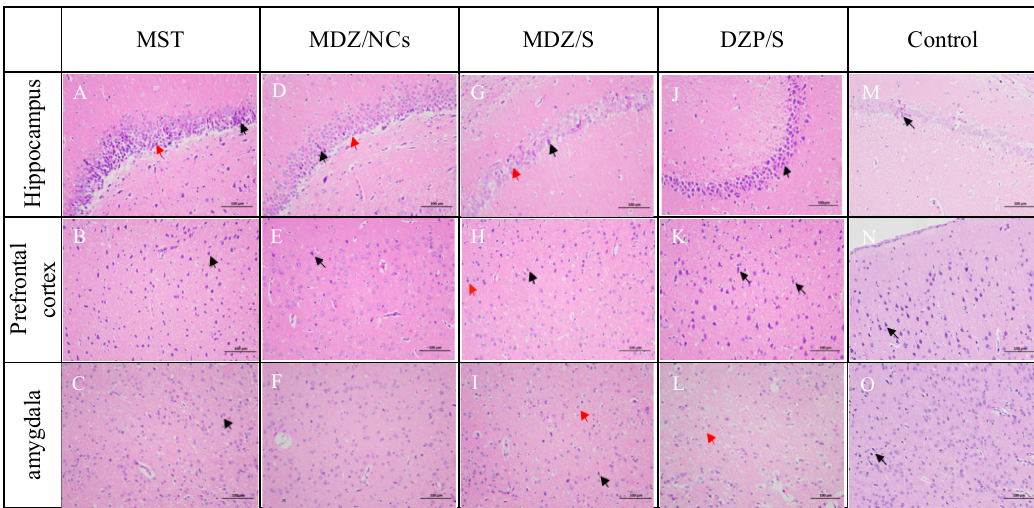
Figure 12. Histopathology of the hippocampus ( A , D , G , J ) and prefrontal cortex ( B , E , H , K ) of rats poisoned with pentrazol ( C , F , I , L ) and treated with MDZ/NCs ( D – F ), MDZ/S ( G – I ), and DZP/S ( J – L ); histopathology of the hippocampus of non-treated rats (MST) ( A – C ). The black arrows indicate pyknotic cells with strong cytoplasmic staining and nuclear condensation. The red arrows indicate edema. The images are shown at 200 × magnification.